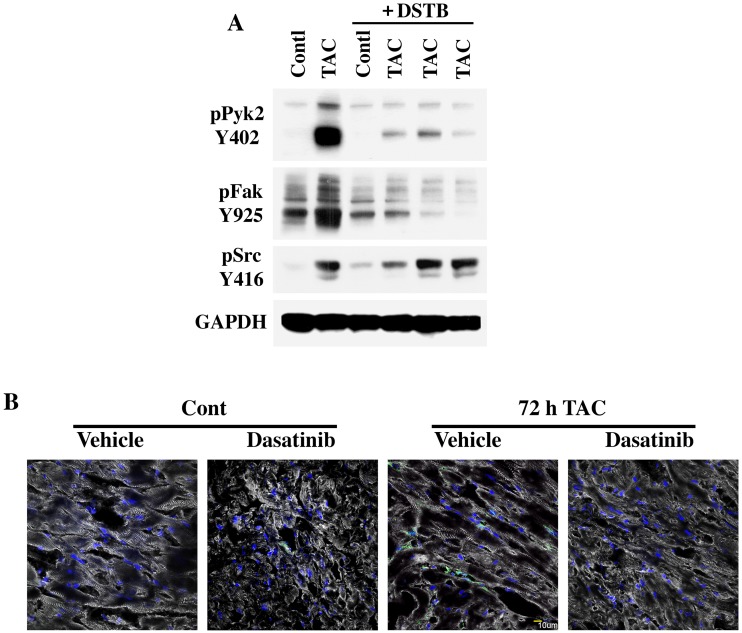
Loss of pressure overload induced nonreceptor tyrosine kinase activation and cell proliferation in LV samples of dasatinib treated mice.Mice were implanted with mini-pumps to deliver either vehicle or dasatinib at 0.44 mg/kg/day for 5 days. Two days after the implantation, they were used either for TAC or sham (control) surgery. After 3 days, hearts were collected and LV tissue samples were processed for Western blot or immunostaining. (A) Protein extracts were used for Western blotting with specific antibodies to detect tyrosine-402 Pyk2, tyrosine-925 Fak and tyrosine-416 c-Src. Western blot with GAPDH antibody was used to monitor protein loading. Results were confirmed in two additional experiments (n = 3). (B) LV tissue sections were used for immunostaining with anti-α-actinin (Grey) and FSP1 (Green) antibodies and nuclear staining with DAPI (blue). Scale bar, 10 μm.